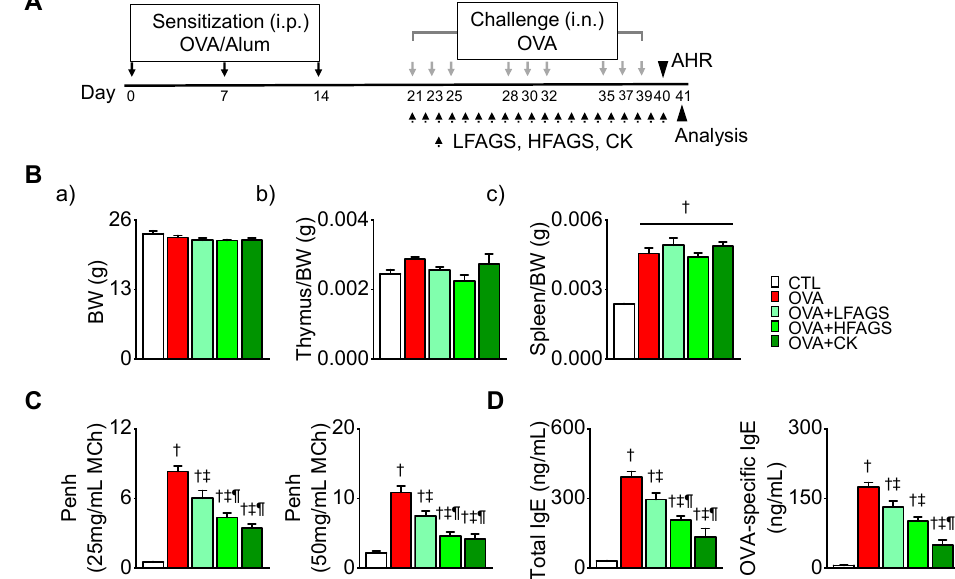
Figure 2. Inhibitory effects of FAGS and CK on OVA-induced airway hyperresponsiveness and IgE production. ( A ) Production of OVA-induced airway allergic asthma mouse model. Time representa- tion of asthma model and pharmacological intervention. The i.p. and i.n. represent intraperitoneal injection and intranasal injection, respectively. AHR represents airway hyperresponsiveness. ( B ) No effects of FAGS and CK on OVA-induced changes in spleen or thymus weight. ( a ) Total body weight. ( b ) Thymus weight/body weight ratio. ( c ) Spleen weight/body weight ratio. ( C ) Assessment of airway hyperresponsiveness in OVA-challenged mice. Airway resistance to direct stimulation (Penh) was measured using MCh at 25 and 50 mg/mL. ( D ) Inhibitory effects of FAGS and CK on total and OVA-specific IgE levels in plasma. Data are shown as mean ± SE (CTL, n = 10; OVA, n = 10; OVA + LFAGS, n = 5; OVA + HFAGS, n = 10; OVA + CK, n = 5). † p < 0.05 compared with CTL. ‡ p < 0.05 compared with OVA. ¶ p < 0.05 compared with LFAGS. § p < 0.05 compared with HFAGS.